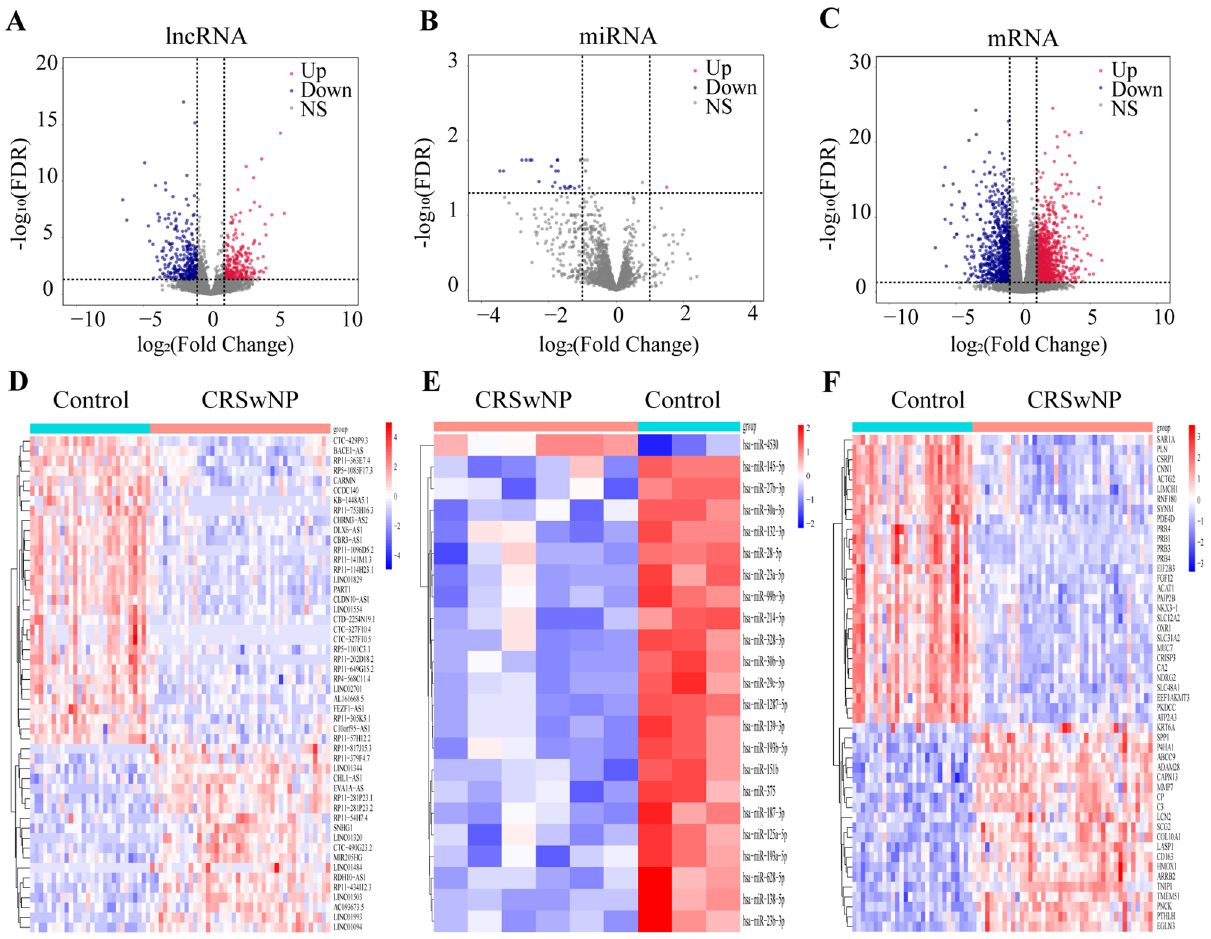
Figure 2. Differentially expressed gene analysis. Red indicates upregulation, blue indicates downregulation, and black indicates no significant difference. ( A ) Volcano map of significantly differentially expressed lncRNAs. ( B ) Volcano map of significantly differentially expressed miRNAs. ( C ) Volcano map of significantly differentially expressed mRNAs. ( D ) Hierarchical clustering heatmap of the top 50 differentially expressed lncRNAs. ( E ) Hierarchical clustering heatmap of all differentially expressed miRNAs. ( F ) Hierarchical clustering heatmap of the top 50 differentially expressed mRNAs. Hierarchical clustering heatmap were generated using the R package “pheatmap” (version 1.0.12. https:// CRAN.R- proje ct. org/ packa ge= pheat Servicebio, Wuhan, China) for the staining of nuclei. Images were captured with a confocal laser scanning microscope (Nikon-A1-Si, Nikon Corporation). Western blotting.